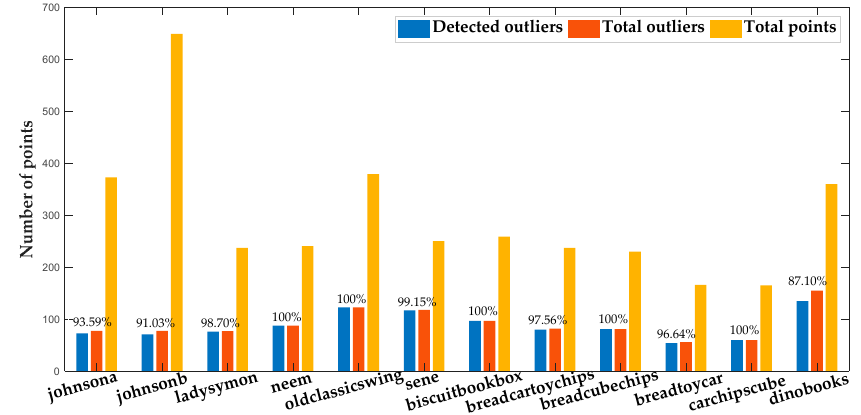
Figure 9. Outlier detection results on individual sequence.